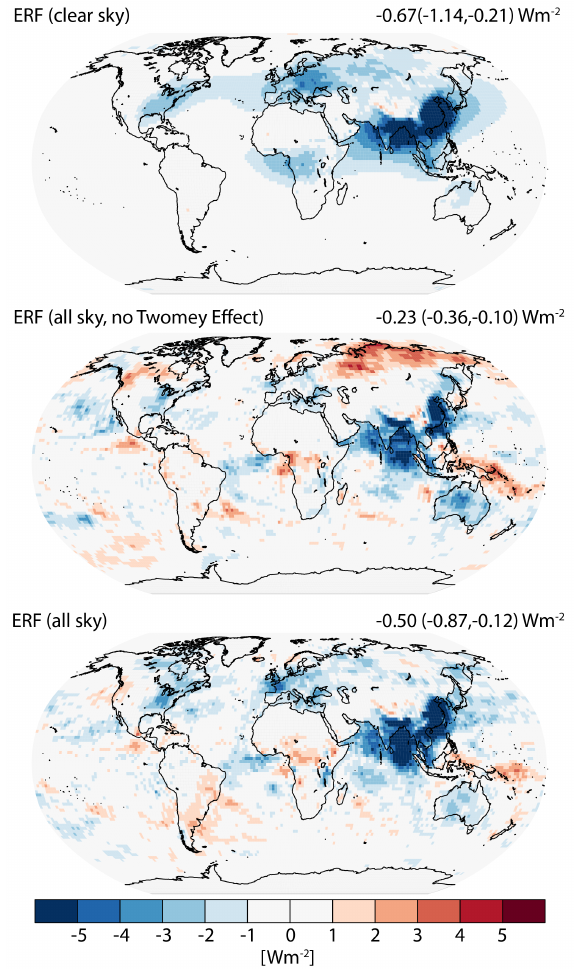
Figure 13. Effective radiative forcing (ERF) and its breakdown into different components: clear-sky ERF (upper panel); all-sky ERF without aerosol–cloud interaction (middle); all-sky ERF with aerosol–cloud interaction (bottom). The numbers on the top right of the figure denote the global mean and the Northern Hemisphere and Southern Hemisphere mean,